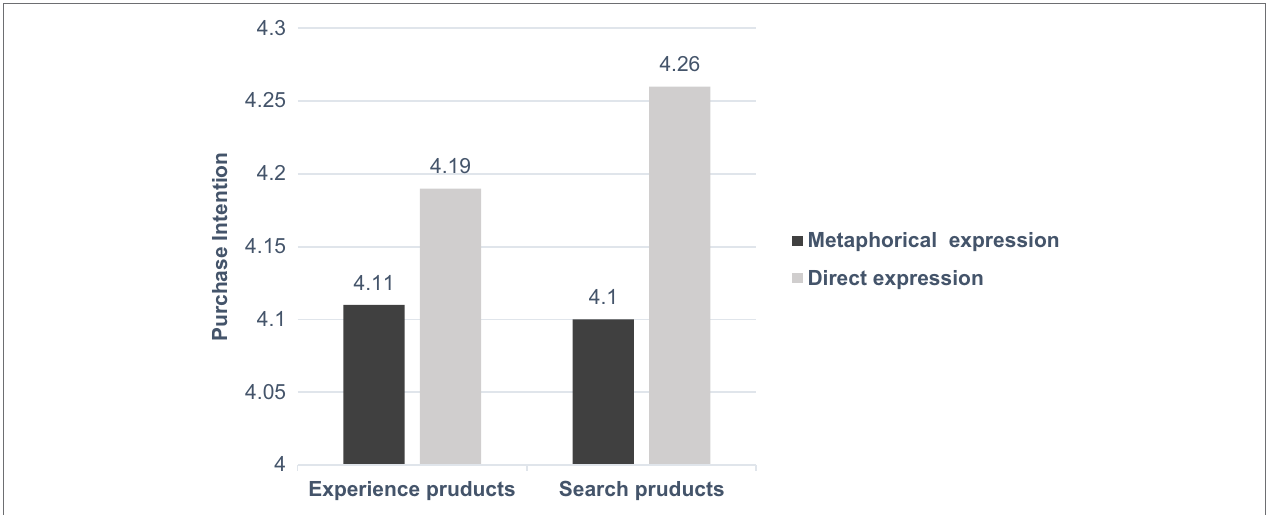
FIGURE 2 | The combined effect of product types and expressions of advertised information on consumers’ purchase intention in low level of personal